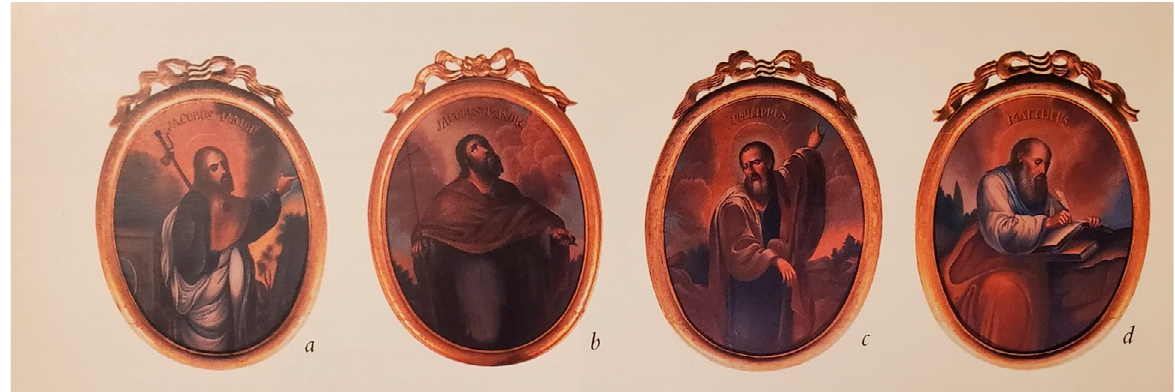
Figure 7. Images of the apostles ( a – d ). Francisco Vel á squez, medallions, end of 18th century, oil on panel, Cathedral